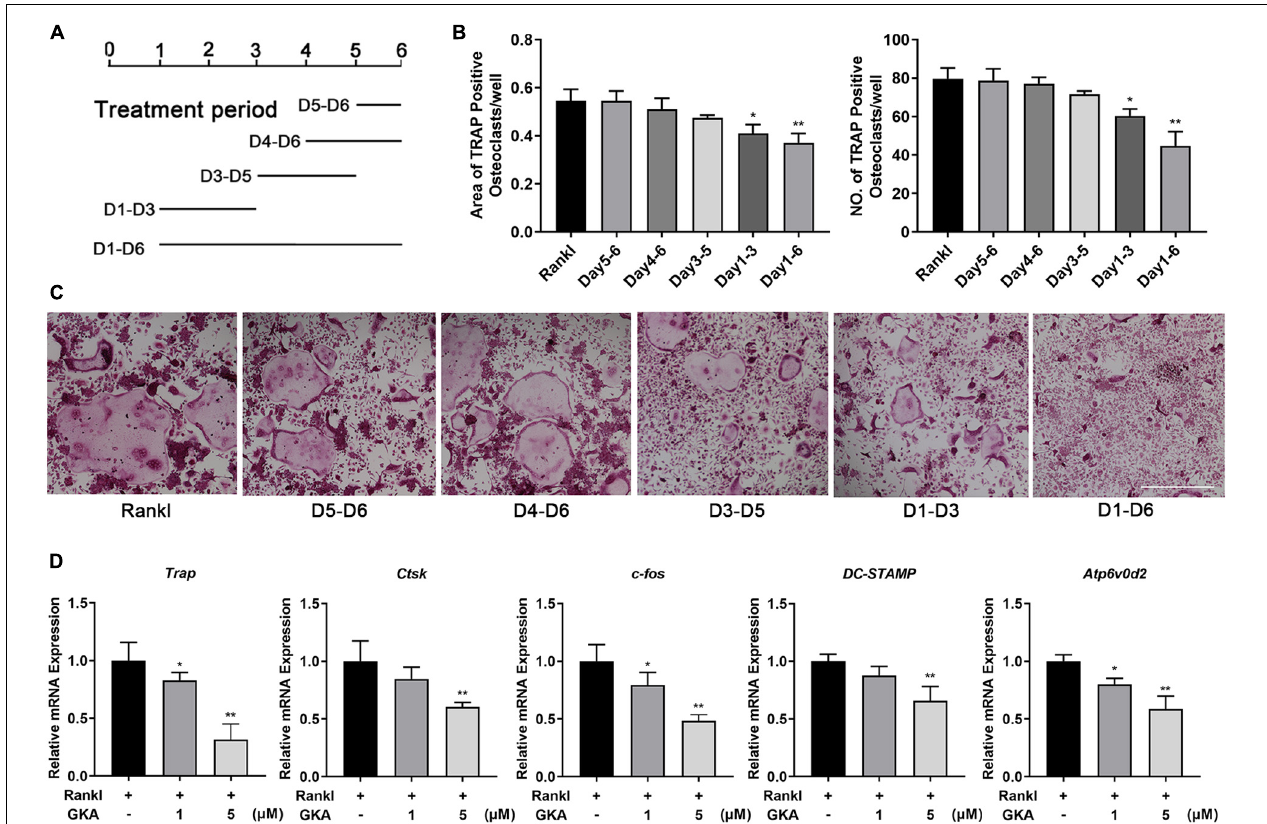
FIGURE 2 | GKA decreased osteoclast differentiation during the early stages of osteoclast differentiation and gene expression in vitro . (A) Schematic diagram of the GKA treatment time. (B) The quantity and area of osteoclasts were determined. (C) BMMs was treated with 5 µ M GKA for the indicated period of time. Representative image of TRAP-positive osteoclasts (scale bar, 500 µ m). (D) The relative expression of osteoclast marker genes ( Trap, ctsk, c-fos, Atp6v0d2, and DC-STAMP ) following GKA treatment was quantified by RT-PCR ( n = 3). The data were described as mean ± SD (* P < 0.05, ** P < 0.01, relative to the control group, analyzed by one-way